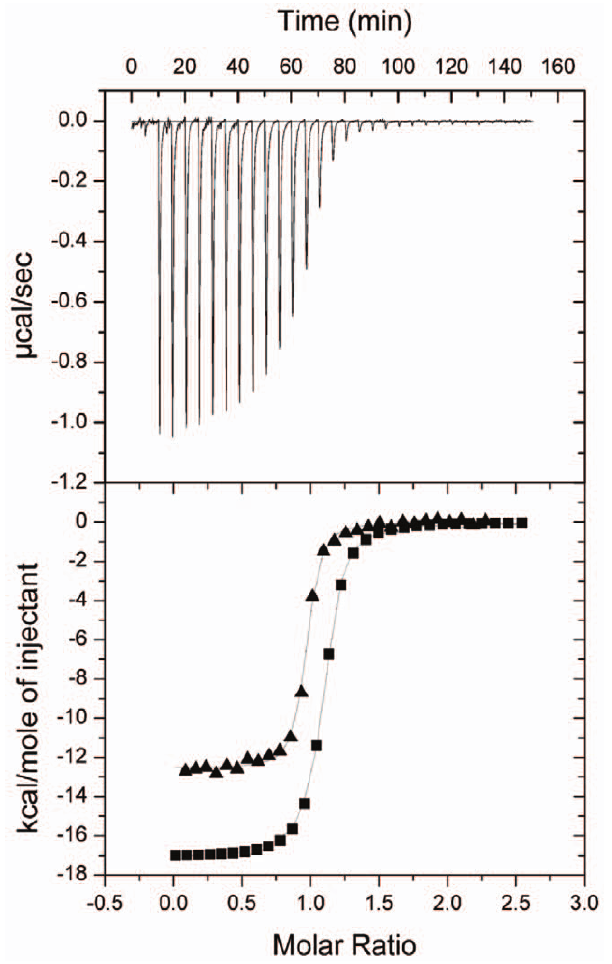
tandem SH3 domains of NOXO1 and peptides p22 phox . Upper part shows the raw calorimetric data for the interaction of p22 phox C and human NOXO1 SH3 AB . Lower part shows the integrated heat changes, corrected for heat of dilution, and fitted to a single site binding model. ( & ) Human p22 phox C titrated into human NOXO1 SH3 AB ( m ) Mouse p22 phox C titrated into mouse NOXO1 SH3 AB .